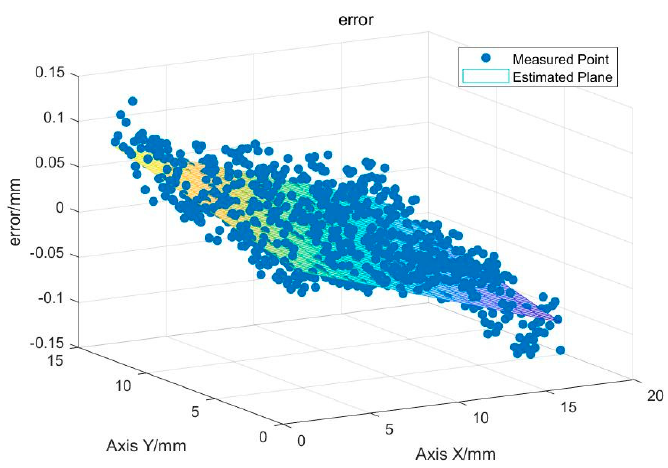
Figure 17. Fitting plane of the standard block upper surface.